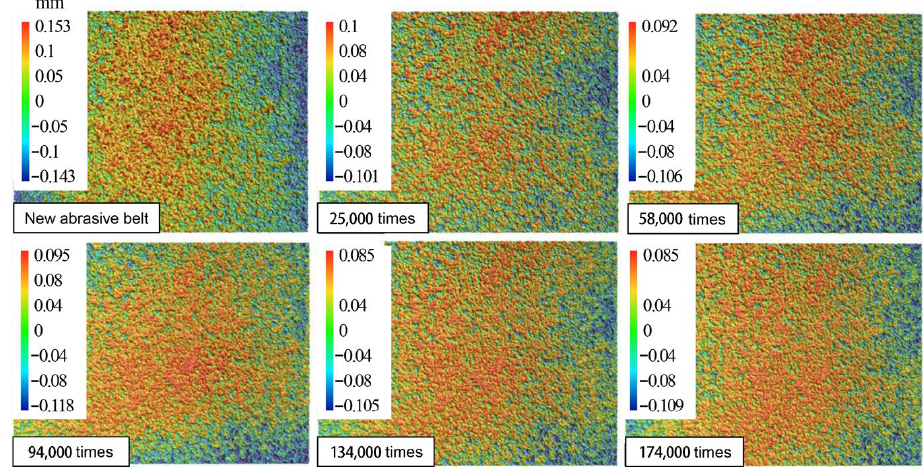
Figure 4. Surface topography of abrasive belt (P120) in MDF sanding.